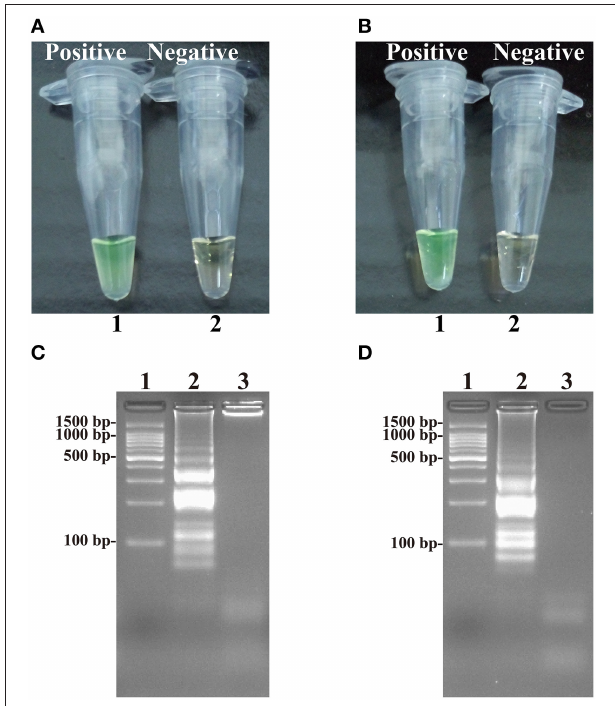
FIGURE 4 | Detection and confirmation of Salmonella - and Shigella -ET-MCDA products in Nonreal-time format. (A,B) Color change of Salmonella - and Shigella -ET-MCDA tubes; tube 1, positive amplification; tube 2, negative amplification. (C,D) 2% agarose gel electrophoresis applied to Salmonella - and Shigella -ET-MCDA products; lane 1, DL 100-bp DNA marker; lane 2, positive ET-MCDA reaction, lane 3, negative ET-MCDA